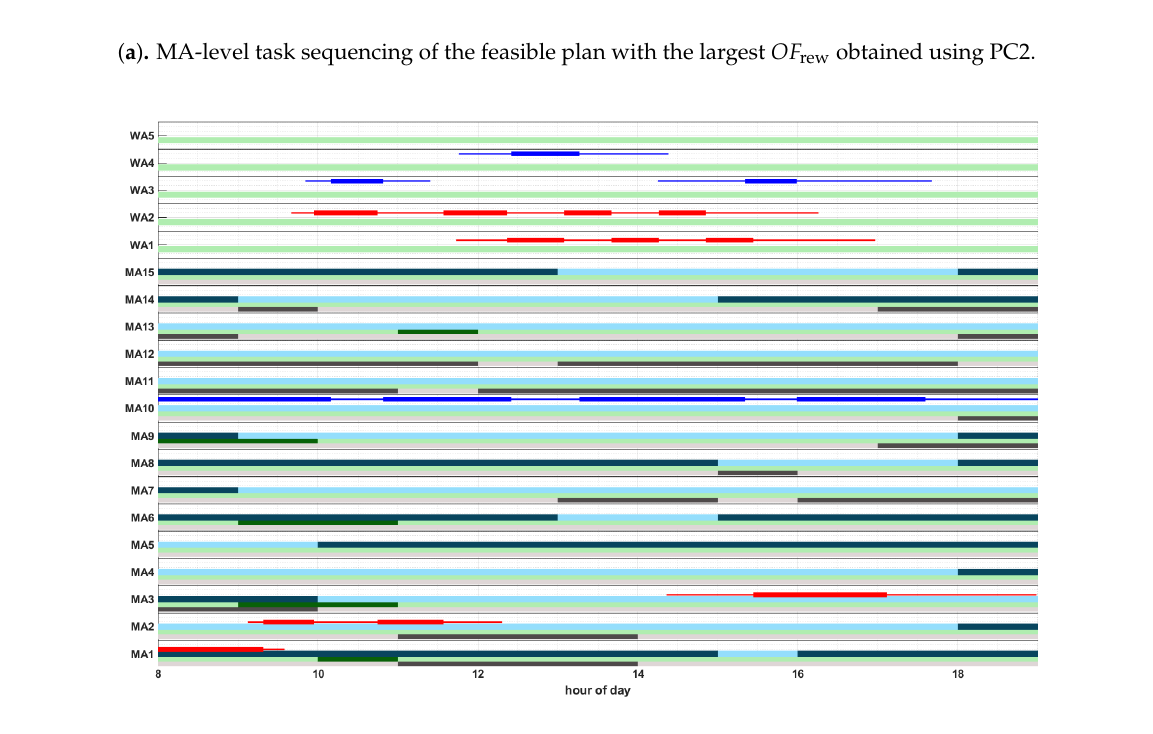
Figure 10. Illustrative examples of feasible plans obtained by PC2 and PC3 for the first scenario